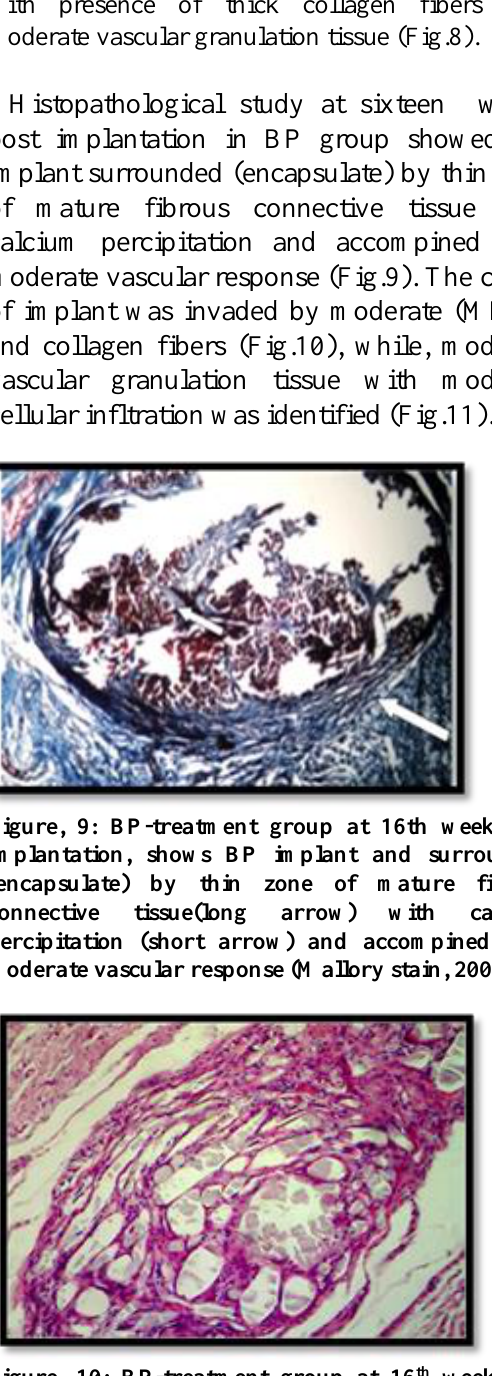
Figure, 10: BP-treatment group at 16 th week post implantation, shows centrally implanted material (long arrow) was invaded by moderate inflammatory cells (MNCs) and collagen fibers (H&E stain, 400X).